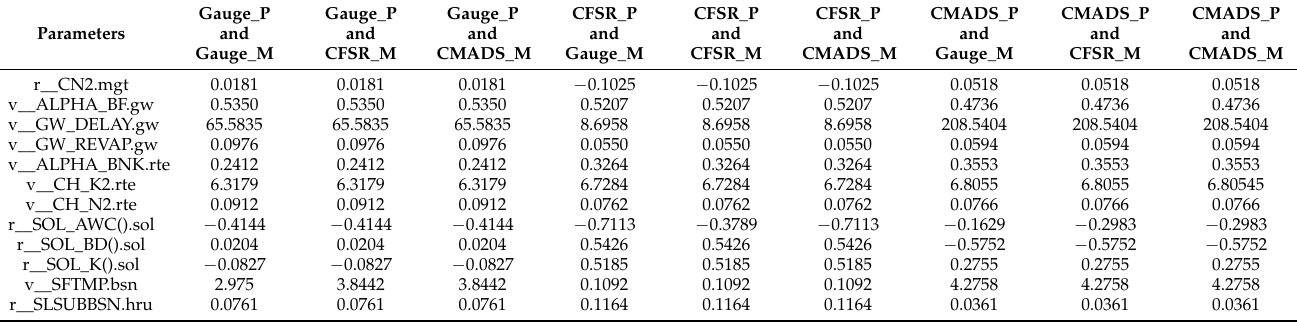
Table 4. Optimal parameters calibrated for the scenarios using the Gauge, CFSR, and CMADS precipitation data. The scenarios using the same precipitation data and different meteorological (excluding precipitation) data often had similar optimal parameters (with the different ones displayed in bold). “Gauge_P” represents using gauged precipitation data, “Gauge_M” represents using gauged meteorological data, and so on.